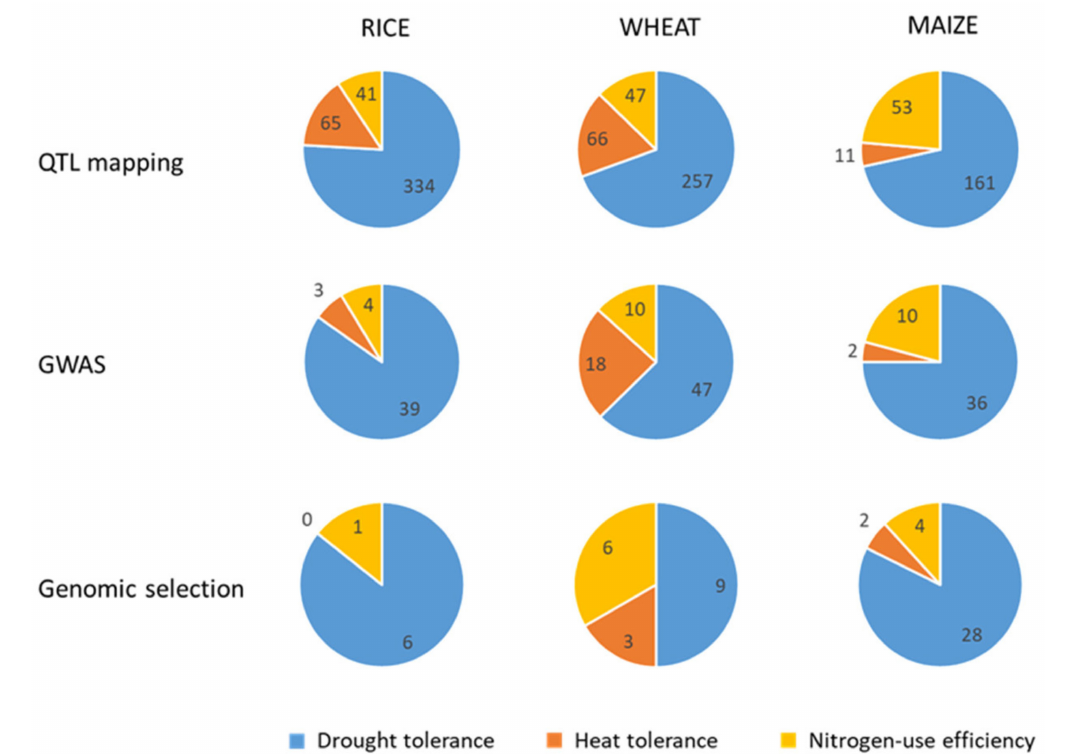
Figure 3. Relative relevance of breeding topics related to the main abiotic stresses and nutrient limitations in bibliographic records referring to QTL mapping, GWAS, and genomic selection, in rice, wheat, and maize (source: Web of Science database, all years available; accessed on 15 December